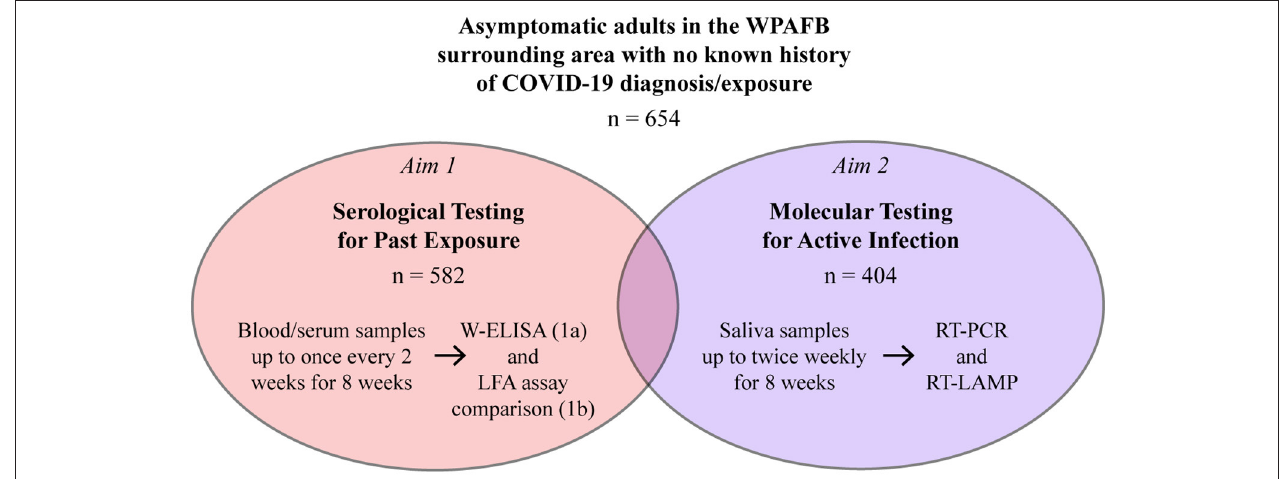
FIGURE 1 | Overview of the study. Participants enrolled in the serosurvey (Aim 1a or Aims 1a and 1b) and/or the molecular survey (Aim 2).